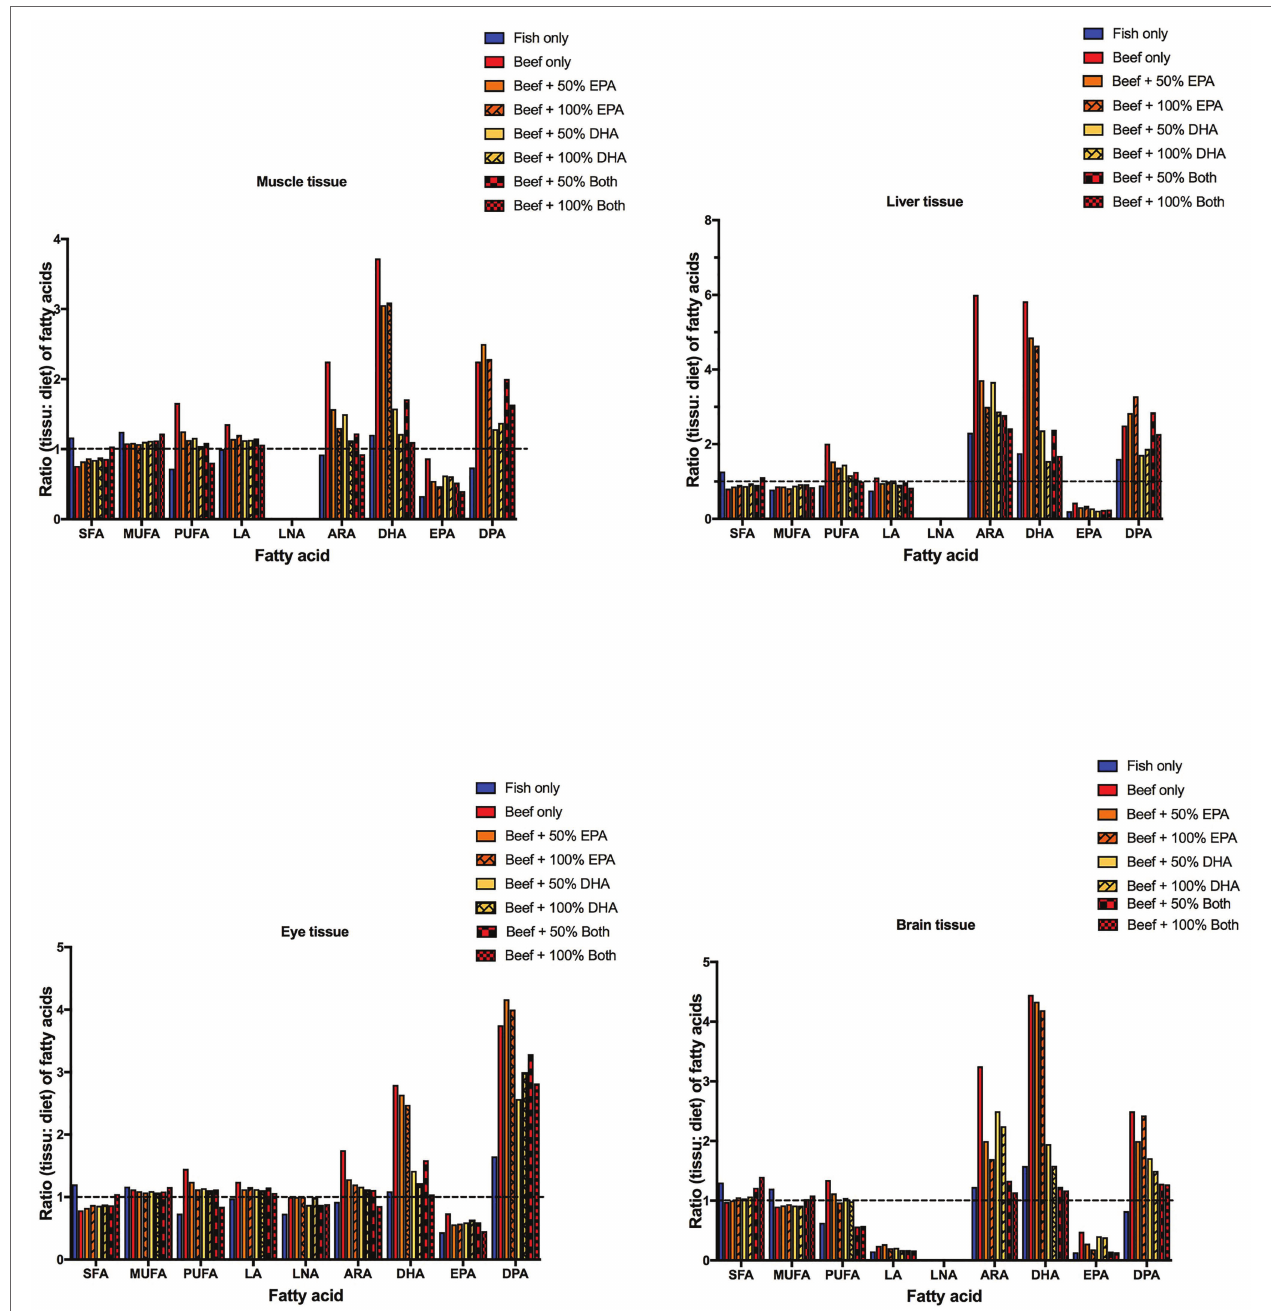
FIGURE 4 | Ratio (tissue: diet) of fatty acid in juvenile Florida pompano ( T. carolinus ) muscle, liver, eye, and brain tissues (41 g average weight). Diet treatments contained fish oil, beef tallow, or beef tallow partially or fully supplemented with EPA, DHA, or both (Rombenso et al., 2017). The dashed lines (ratio = 1) indicate equal amounts of fatty acids in juveniles and in the diet. LA, linoleic acid; LNA, linolenic acid; ARA, arachidonic acid; DHA, docosahexaenoic acid; EPA, eicosapentaenoic acid; SFA, saturated fatty acids; MUFA, monounsaturated fatty acids; and PUFA, polyunsaturated fatty